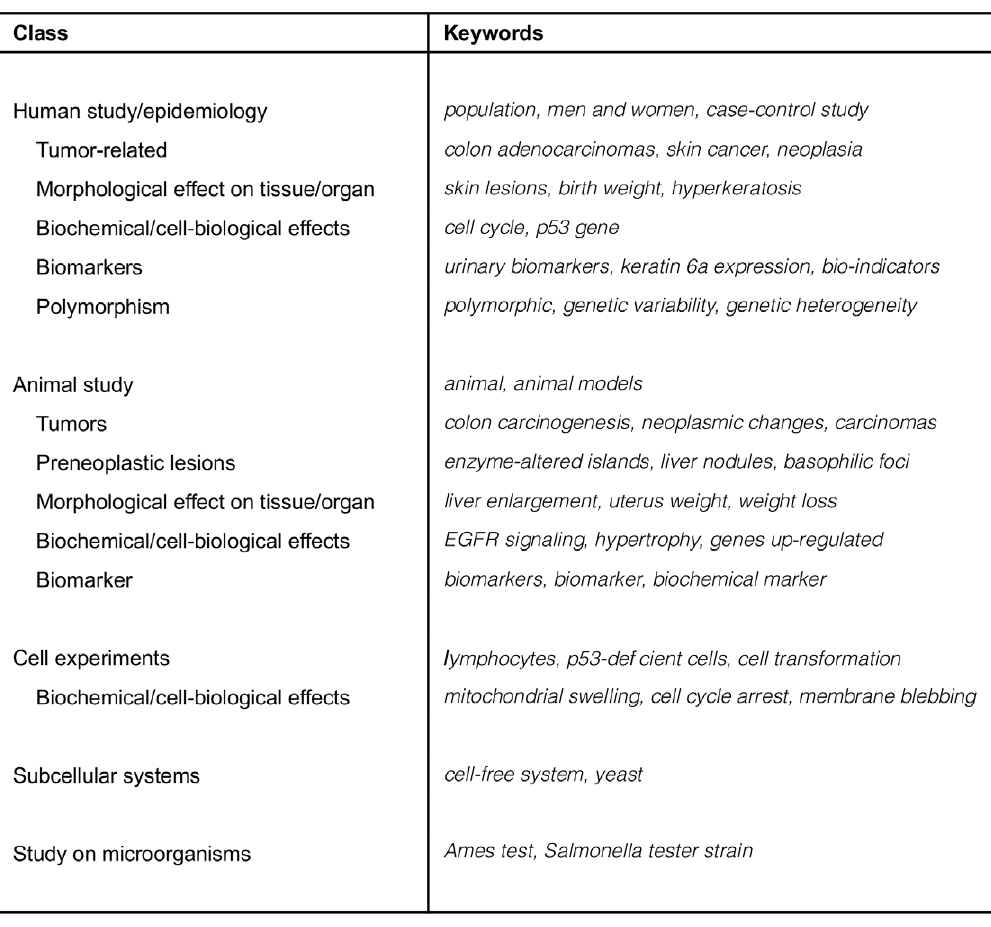
Figure 3. Example keywords for the ScientificEvidenceforCarcinogenicActivity taxonomy.